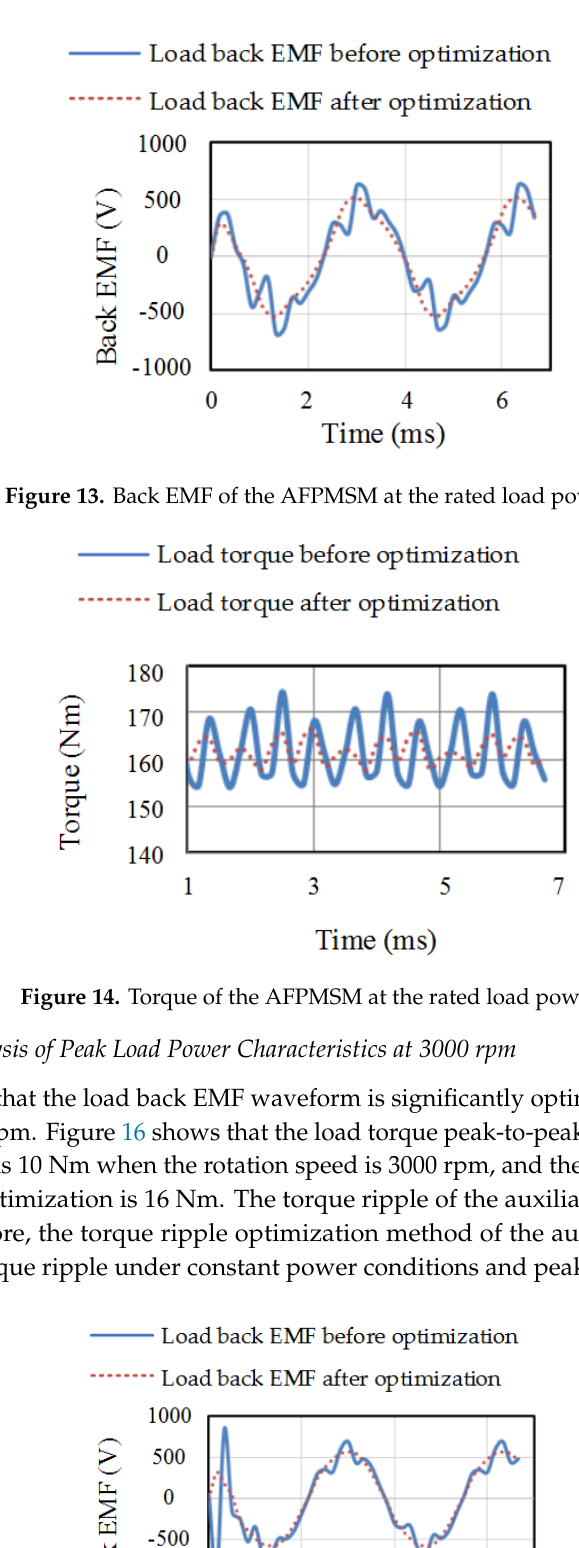
Figure 15. Back EMF of the AFPMSM at the peak load power.